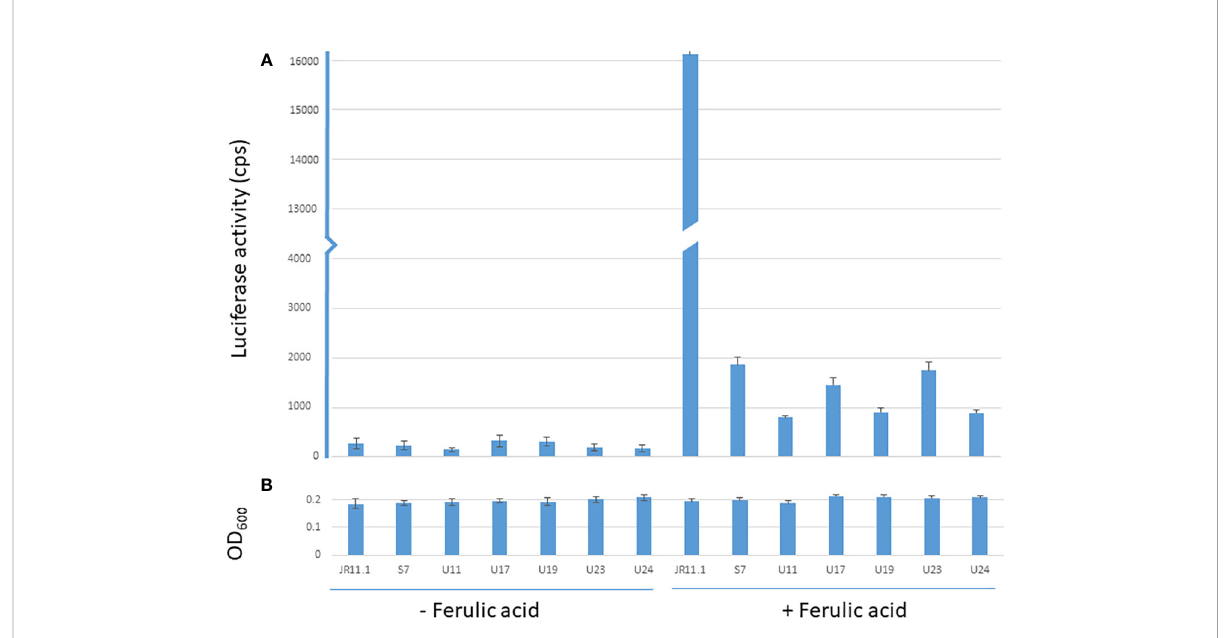
FIGURE 4 Luciferase and OD 600 values of the reporter strain and mutants under non-inducing and inducing conditions. Luminescence values (cps) of reporter strain JR11.1 and mutants derived from JR11.1 (S7, U11, U17, U19, U23 and U24) were compared to parental strain JR11.1. Strains were grown in MM with D-fructose as carbon source without or with 5 mM ferulic acid as inducer. Luciferase activity (A) and OD 600 values (B) after 20 hours of growth at 30 °C are